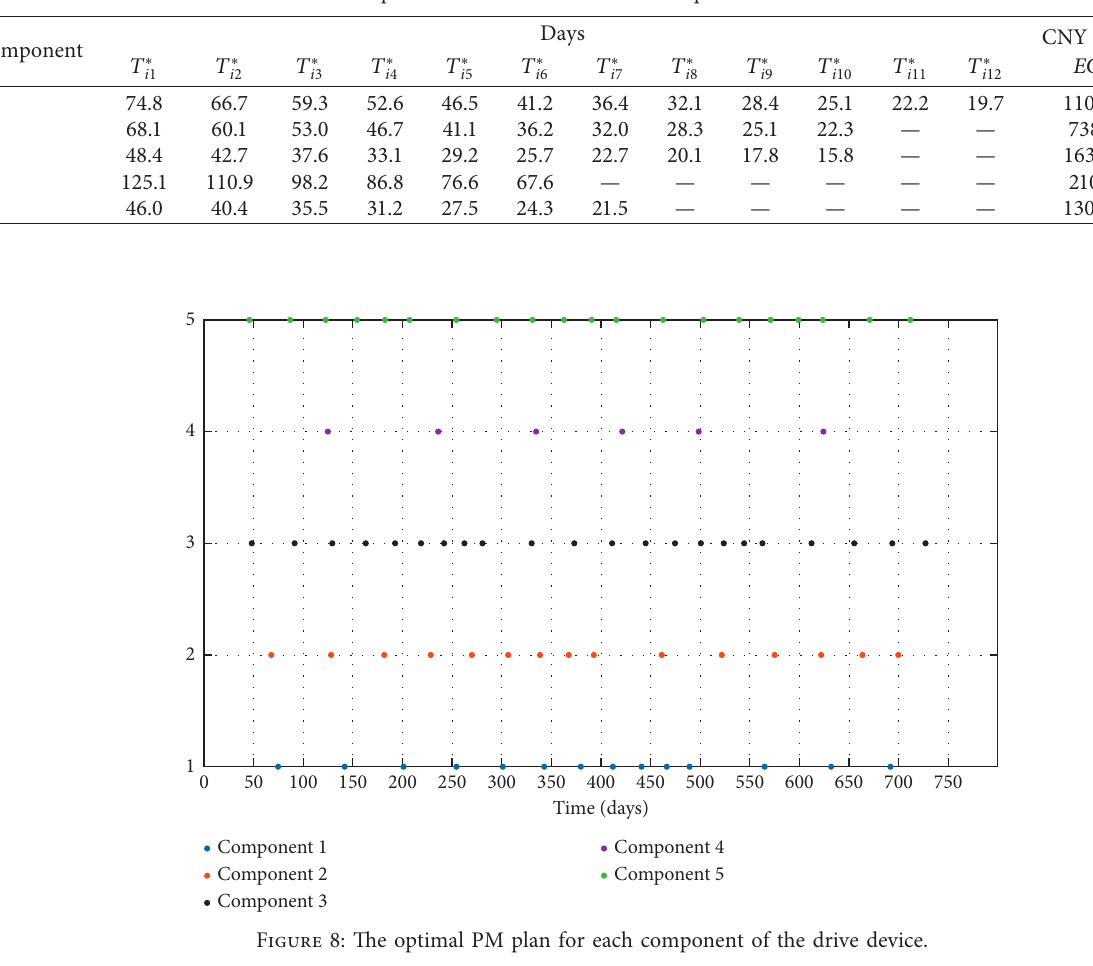
Table 2: The optimal PM schedule for each component of the drive device.